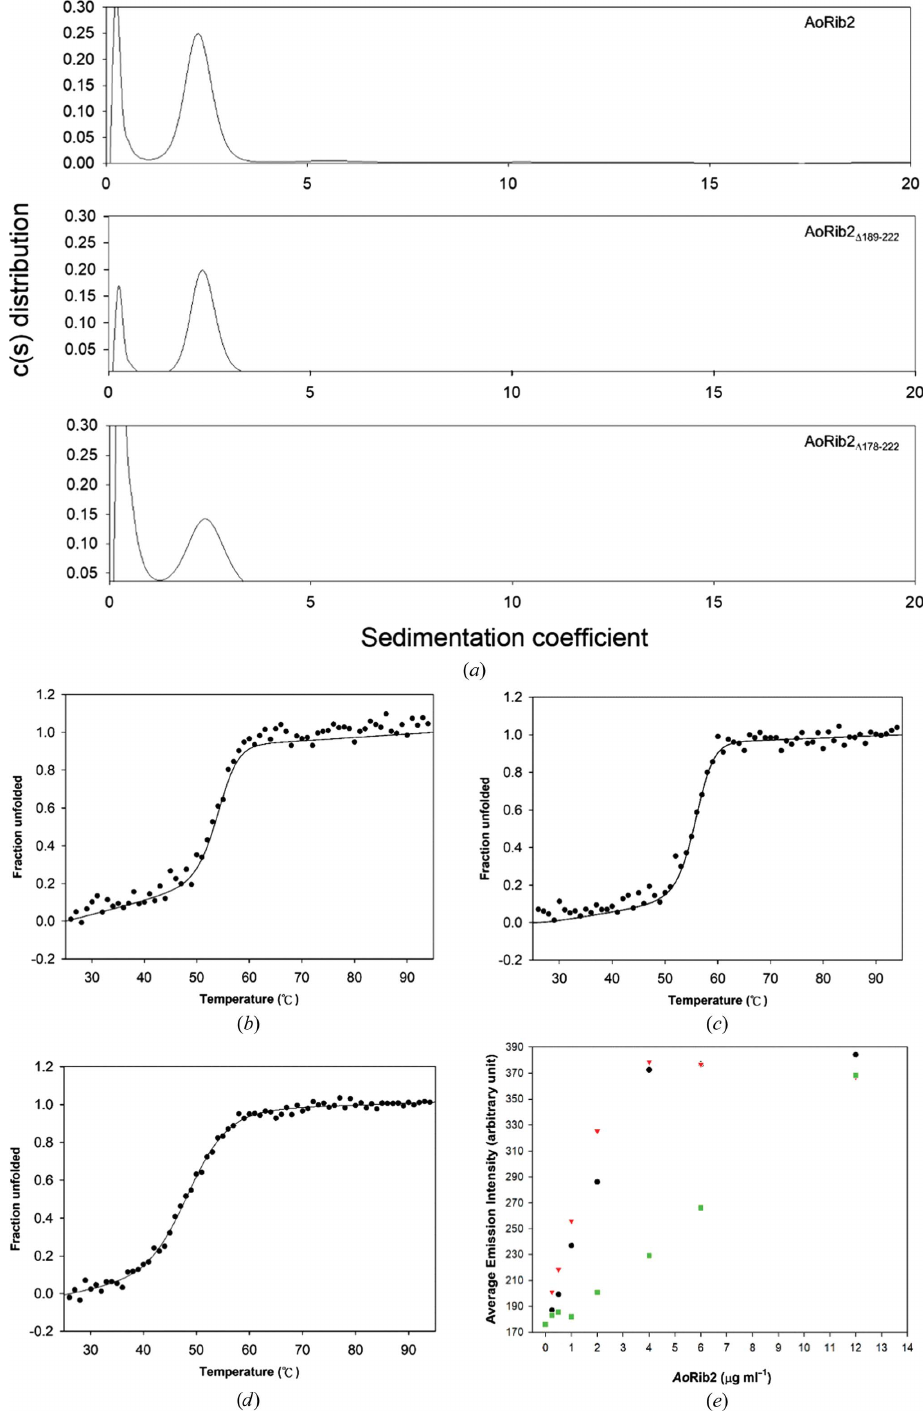
Figure 6 ( a ) Sedimentation-velocity analysis of AoRib2 deletion mutants. Top, AoRib2 188 ; bottom, AoRib2 177 . The two deletion mutants were found to exist in a monomeric form. To compare protein stability, equilibrium thermal denaturation CD measurements of ( b ) AoRib2, ( c ) AoRib2 188 and ( d ) AoRib2 177 were conducted in 20 m M sodium phosphate pH 7.5. ( e ) A plot of the average fluorescence emission intensity against protein concentration for AoRib2 (black circles), AoRib2 188 (red inverted triangles) and AoRib2 177 (green